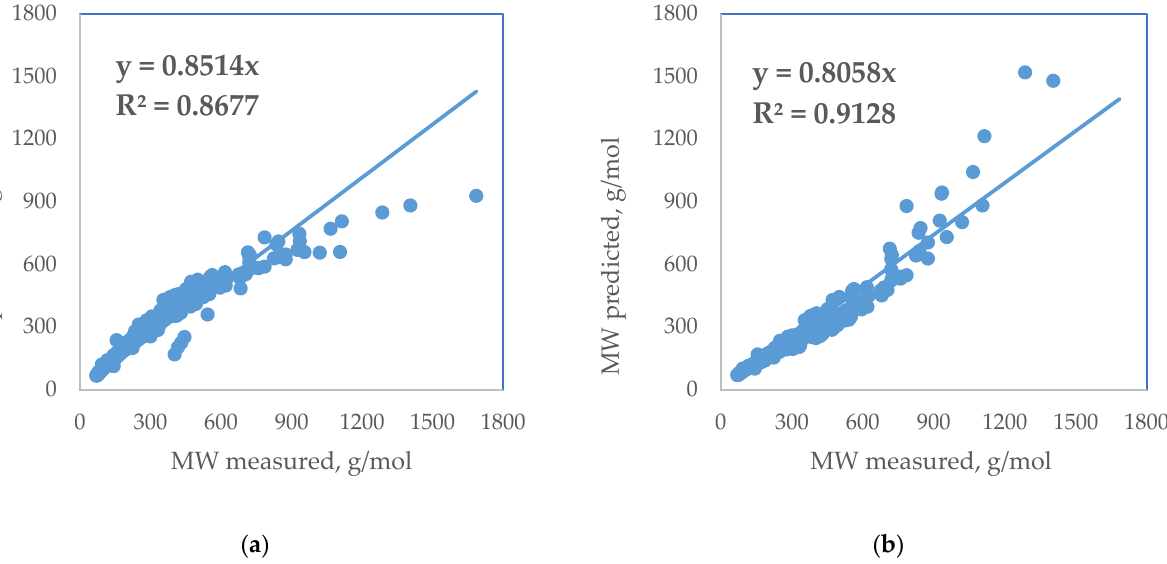
Figure 8. Parity graph for predicted versus measured molecular weight by Equation (2) (Kesler and Lee) ( a ) and by Equation (4) (Twu) ( b ).